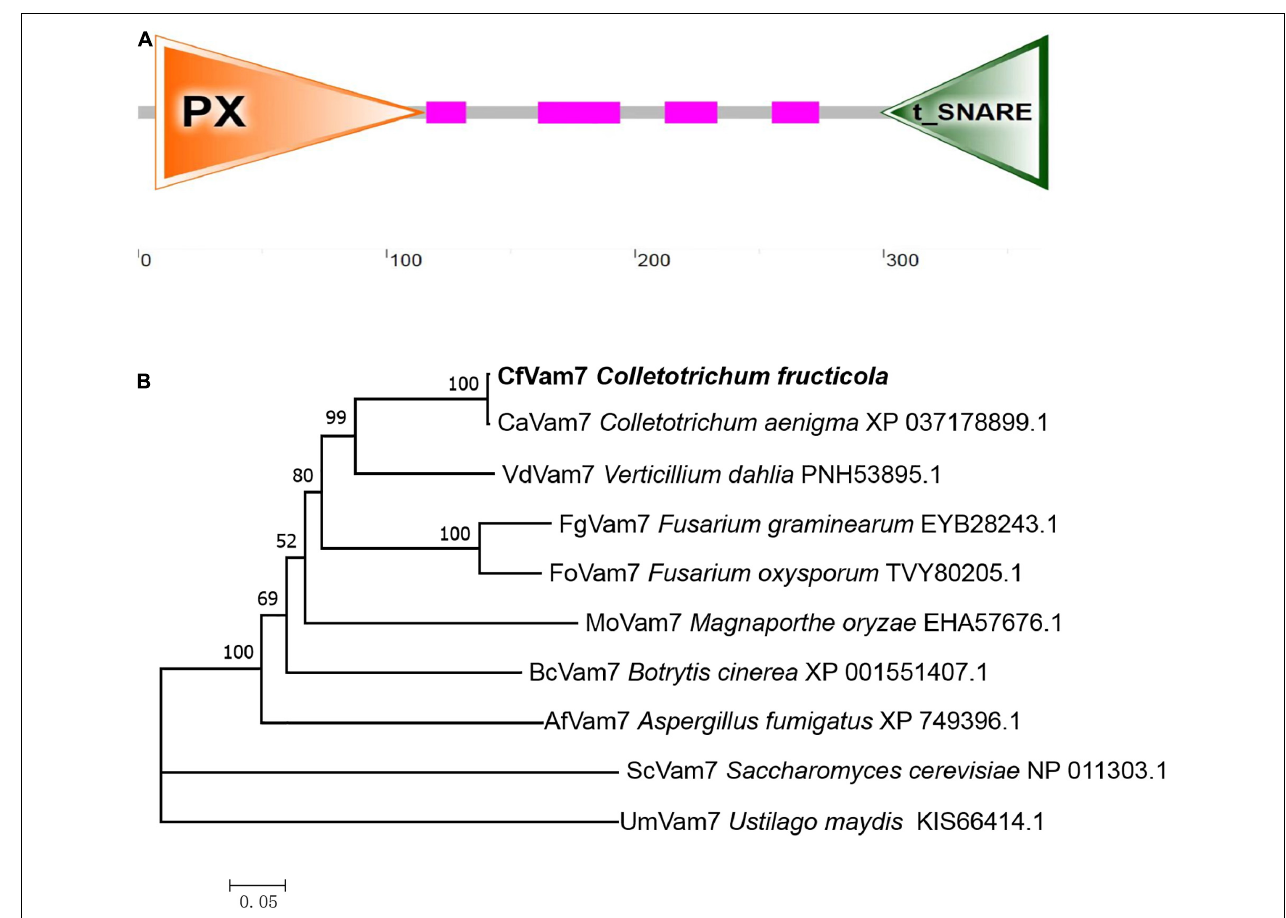
FIGURE 1 | Domain prediction and phylogenetic analysis of CfVam7. (A) The domain prediction of CfVam7. The orange triangle (7–115 amino acids) indicates the PHOX (PX) domain, and the green triangle (299–366 amino acids) refers to the t_SNARE domain. (B) The phylogenetic tree was constructed using MEGA 7.0 and the neighbor-joining method with 1,000 bootstrap